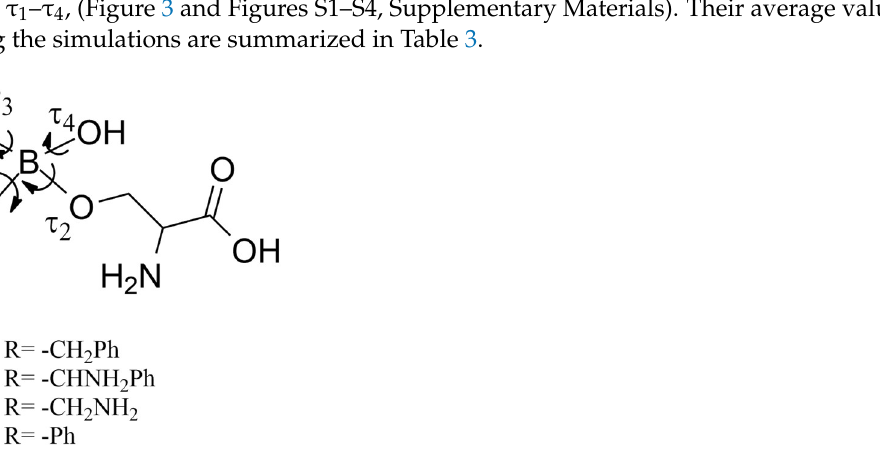
Figure 3. Torsional angles of compounds 1 – 4 evaluated during the MD simulations. Table 3. Average values of dihedral angles τ 1 – τ 4 for BCCs 1 – 4 , which resulted from MD simulations.